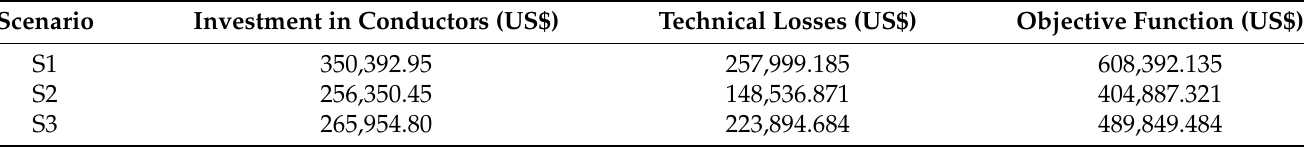
Figure 9. Voltage profile at each node for the hours of maximum demand in the three stages of case 2 of the test system 1. Table 18. Investment and operating costs in test system